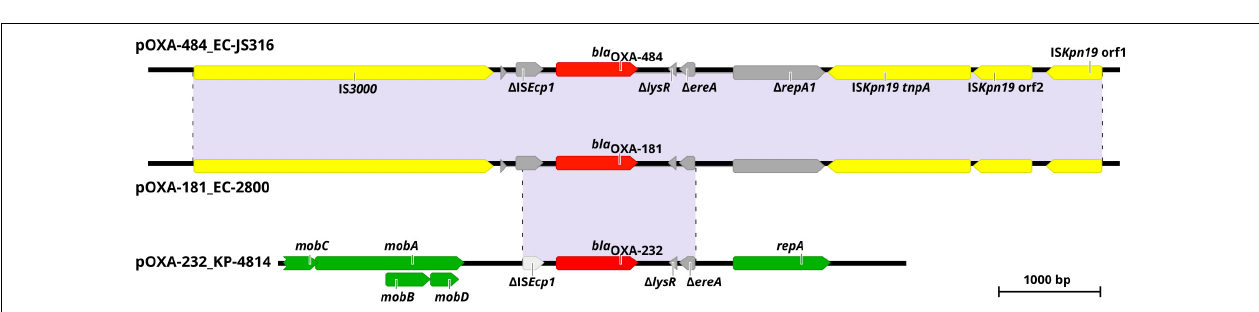
FIGURE 2 | Genetic environment of bla OXA - 484 , bla OXA - 181 , and bla OXA - 232 within pOXA-484_EC-JS316, pOXA-181_EC-2800, and pOXA-232_KP-4814. Colored arrows indicate insertion elements (yellow), fragmented genes (gray), antibiotic resistance genes (red) and genes of the plasmid backbone (green). Shaded regions between the plasmids share > 99% nucleotide sequence